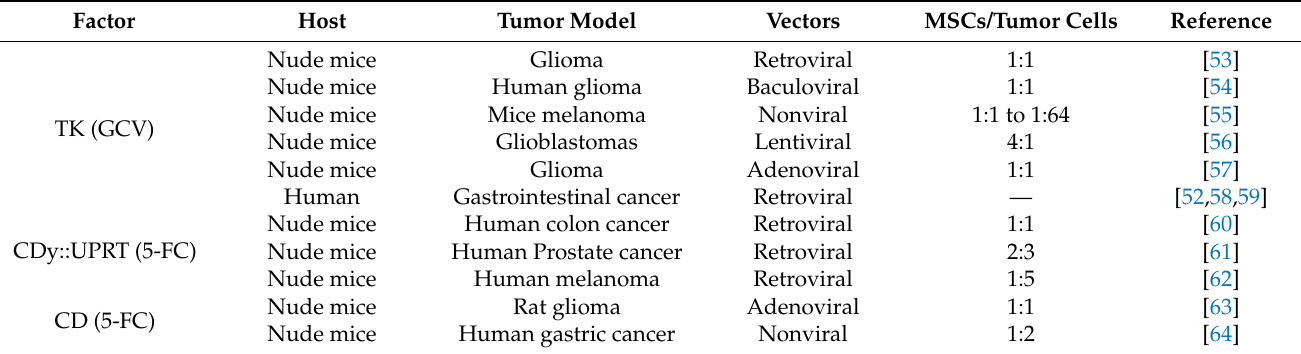
Table 1. GDEPT of cancers using